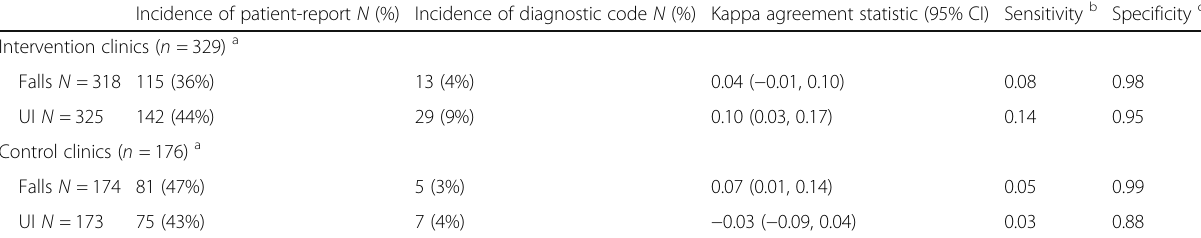
Table 3 Kappa Agreement between PROMs and electronic medical